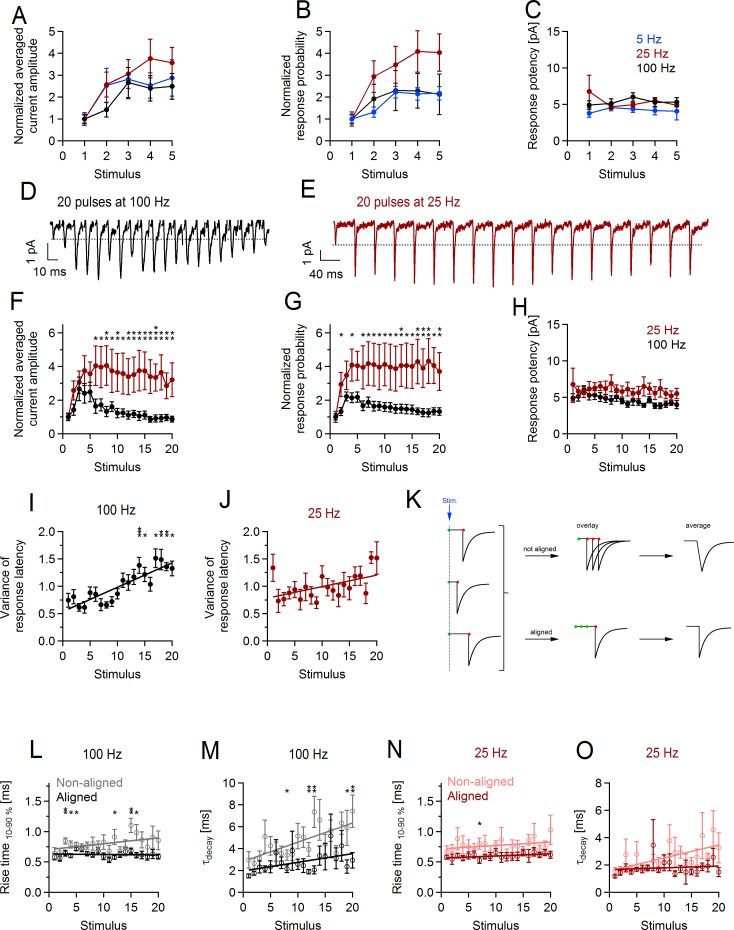
Short-term facilitation and desynchronization of glutamate release at axon-glia synapses during the train depend on the stimulation paradigm.(A–B) Normalized average current amplitude including failures and response probability and (C) absolute response potency during minimal stimulation train of 5 pulses at 5 Hz (n = 5 cells), 25 Hz (n = 11 cells), or 100 Hz (n = 19 cells). Each point represents mean ± SEM. The values for each stimulus were compared between the different paradigms with one-way ANOVA. No statistically significant differences were found (S5 Data). (D, E) Example traces showing average currents (including failures) in two oligodendrocyte precursor cells (OPCs) upon minimal stimulation with 20 pulses at (D) 100 Hz and (E) 25 Hz. Fifty sweeps were averaged for each paradigm. Stimulation artifacts are truncated for clarity. Dotted lines are drawn at the level corresponding to the peak amplitude of the first response within the train. (F, G) Normalized average current amplitude including failures and response probability and (H) absolute response potency during minimal stimulation train of 20 pulses at 25 Hz (n = 6 cells) or at 100 Hz (n = 14 cells). Independent sample t test (S5 Table). (I, J) Average variance of onset latency of the phasic responses during the stimulation train of 20 pulses at (I) 100 Hz (n = 14 cells) or (J) 25 Hz (n = 6 cells). Paired t test was used to compare the value for each stimulus to the value at the first stimulus (S6 Table). (K) Schematic drawing explaining two approaches for generating average current waveforms used to study desynchronization of release during the train. The results of this analysis are shown in panels (L–O). Bottom row (“aligned”): events are aligned on the time of their onset (red dot) and then averaged. Top row (“not aligned”): average event is generated from the raw traces, which are by default aligned on the stimulation time (green dot) but not on their onset. If desynchronization of release occurs during the train while properties of individual events do not change, it is expected that (1) kinetics of the average nonaligned event is slower at the end of the train than at the beginning, and (2) kinetics of the average aligned event does not change during the train. (L, N) Average rise time and (M, O) average decay time constant of aligned and nonaligned responses (excluding failures) after each stimulus within the train of 20 pulses at (L, M) 100 Hz or (N, O) 25 Hz. Average aligned and average nonaligned events for each stimulus were generated as explained in (K). The same cells were used as in (F–J). Independent sample t test was used to compare the values from nonaligned and aligned averages for each stimulus (S7 Table). *p < 0.05; **0.001 < p < 0.01. The numerical data used in A–C, F–J, and L–O are included in S6 Data.